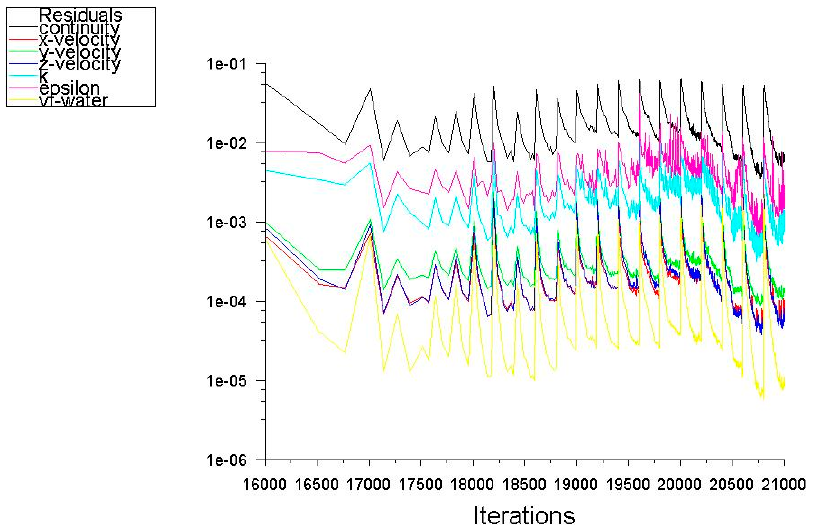
Figure 9. Convergence plots of residuals for separator.